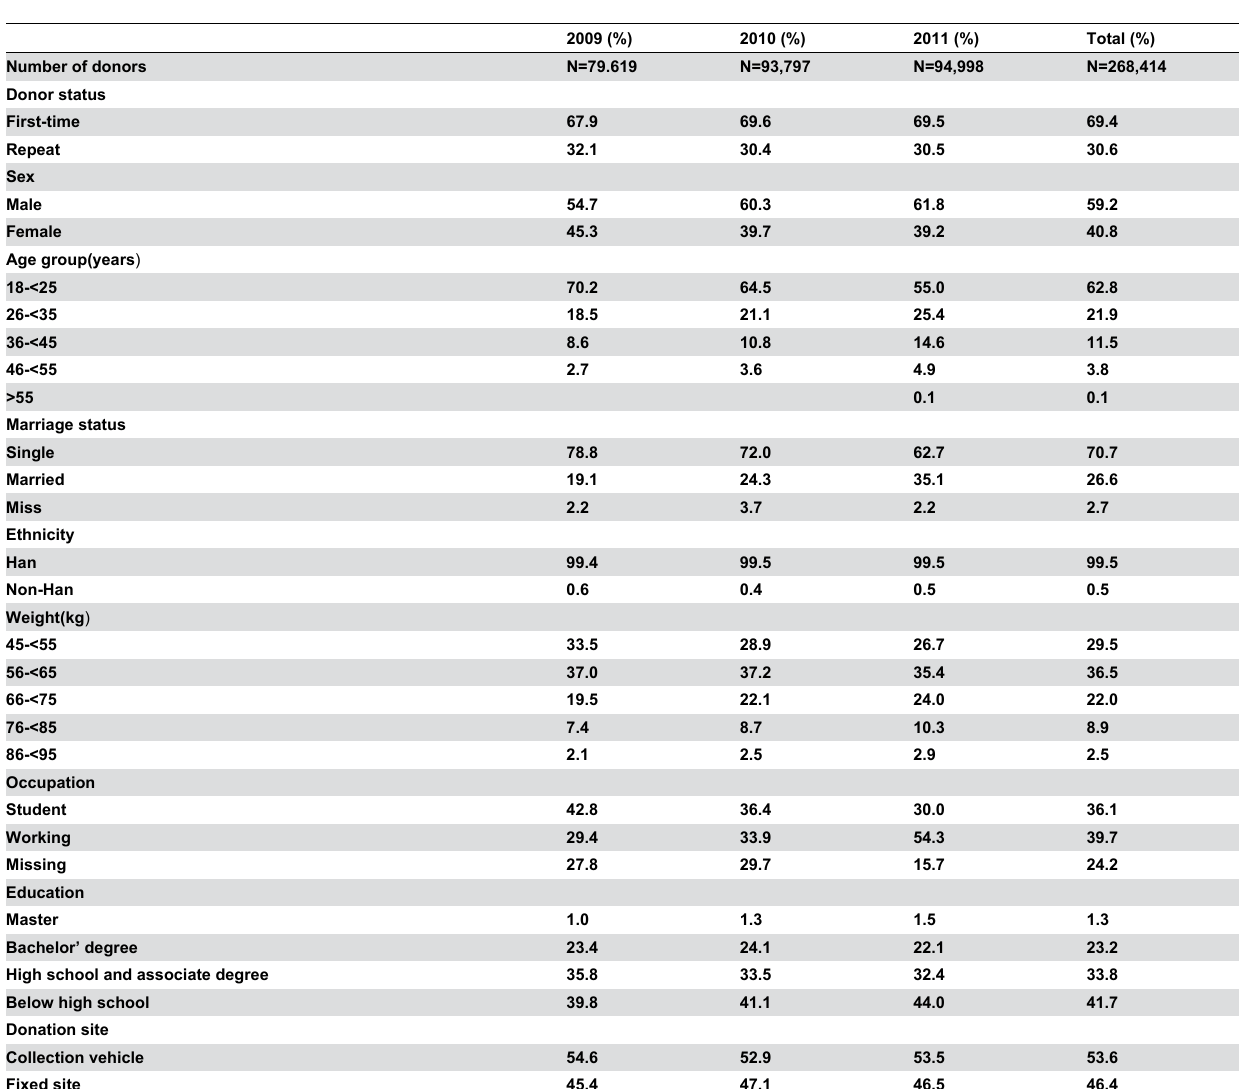
Table 2. Demographic characteristics associated with all donors in Anhui from 2009 to